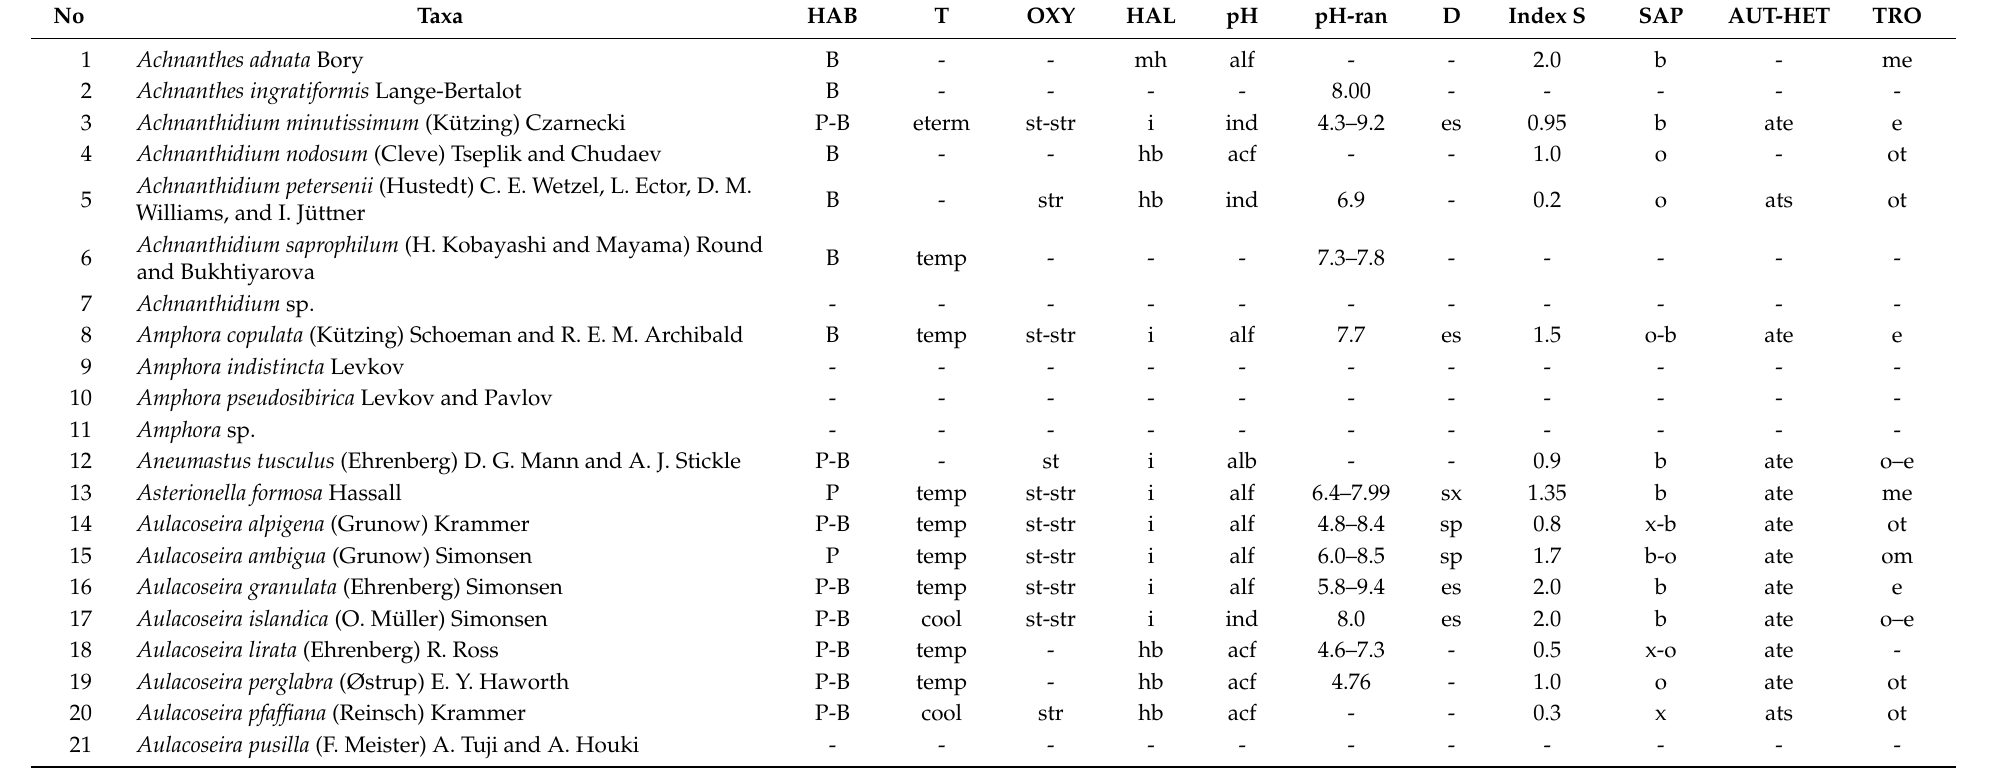
Table A3. Diatom species ecological preferences in 14 studied water bodies in the vicinity of Tiksi Bay, July